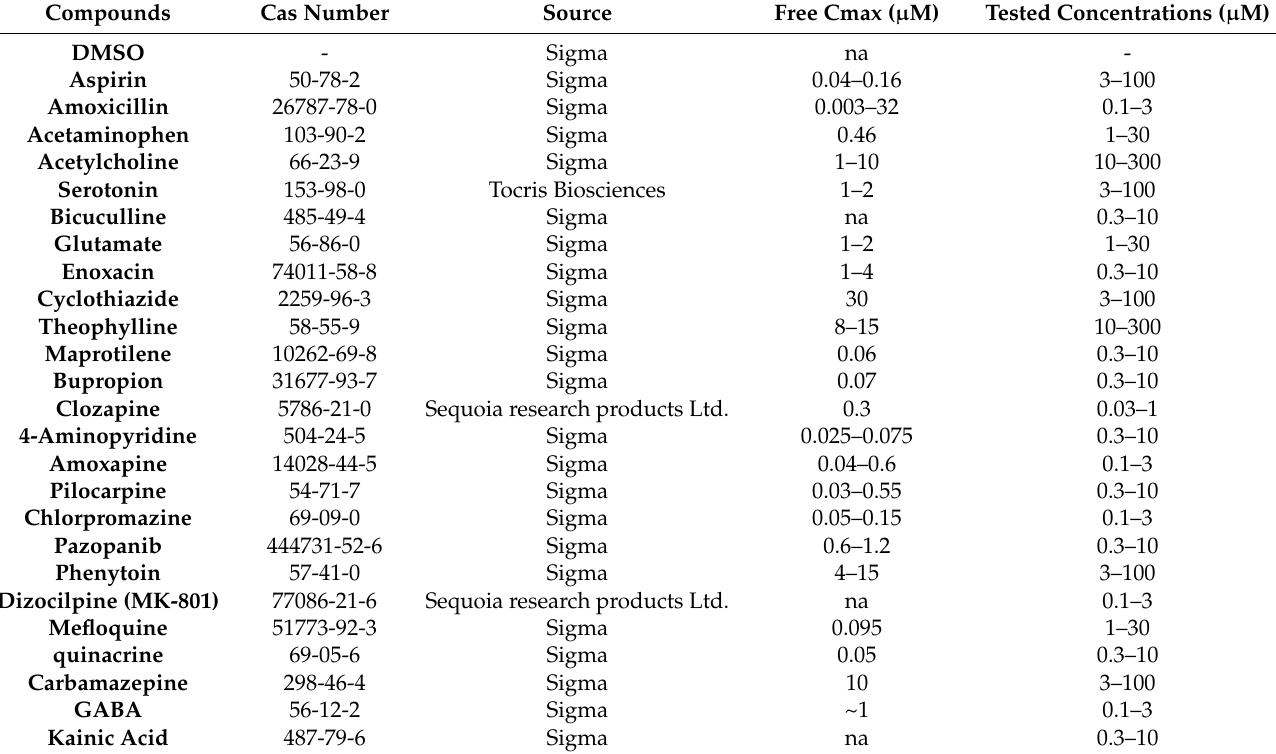
Table 1. The list of reference drugs tested in hiPSC-derived neurons co-cultured with